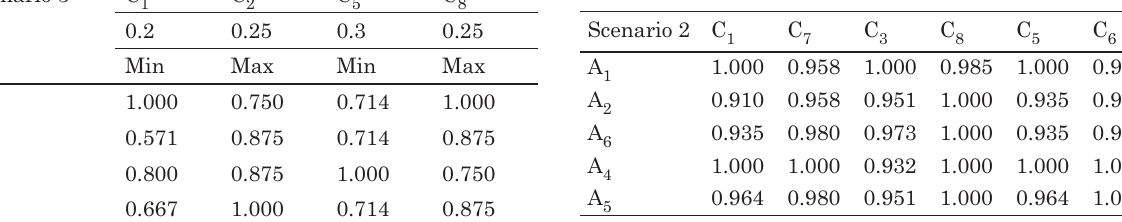
Table 11. Weighted and normalized decision-making matrix for the multiplication part (second scenario)